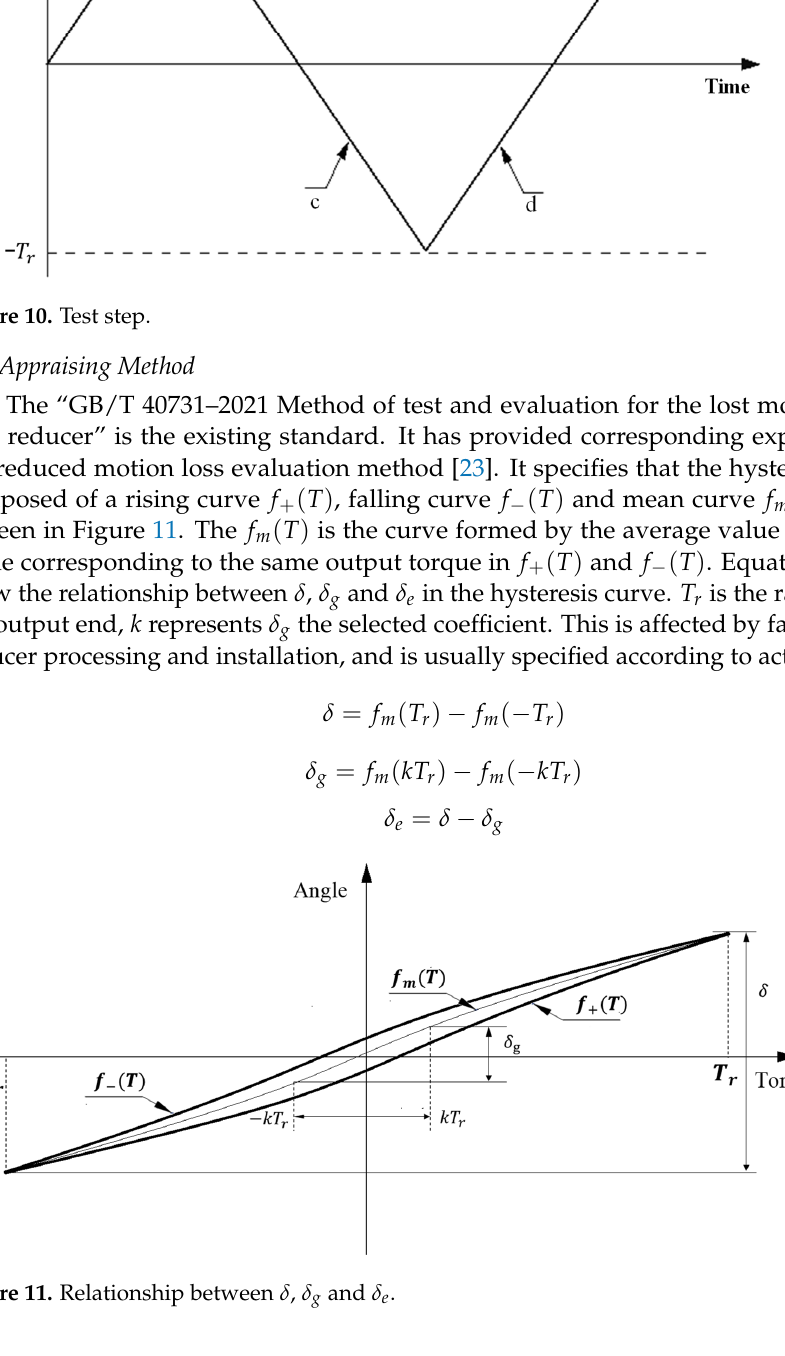
Figure 11. Relationship between 𝛿 , 𝛿 (cid:3034) and 𝛿 (cid:3032)